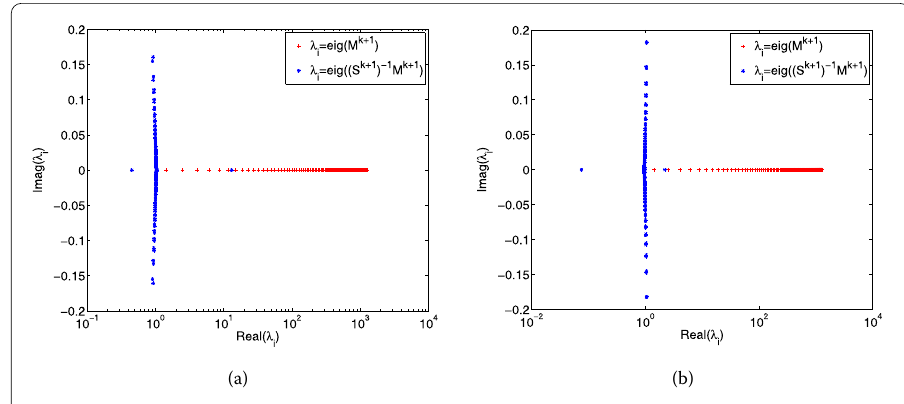
Figure 2 Spectrum of original matrix (red) and preconditioned matrix (blue) for Example 5.1 at time level ( a ): k = 0 and ( b ): k = 1, respectively, when M = N = 128, α = 0.5, q = 10, β = 1.8, and T = 0.75